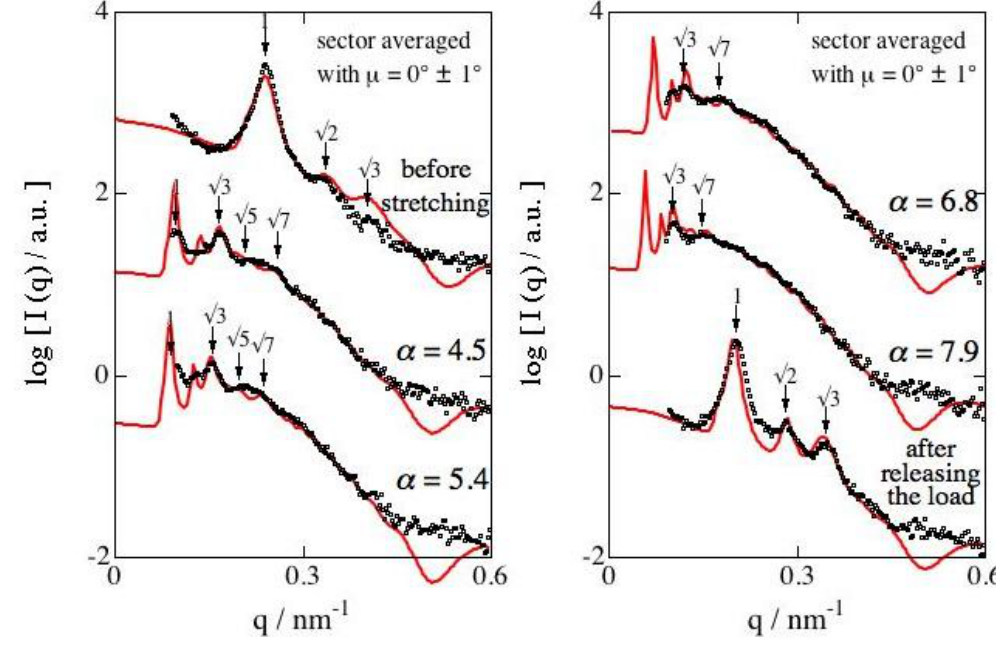
Figure 5. 1d-SAXS profiles parallel to the stretching direction converted from the 2d-SAXS patterns shown in Figure 4 by conducting the sector averaging over the azimuthal angle range with  = 0° ± 1°. The solid curves are the results of the calculated profiles based on the bcc